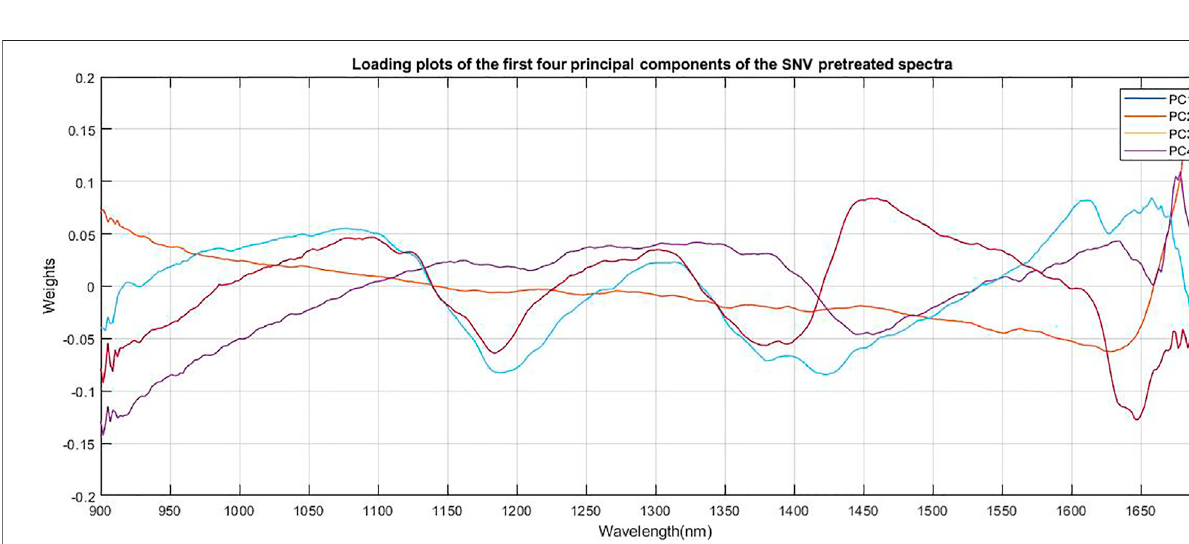
Frontiers in Pharmacology |